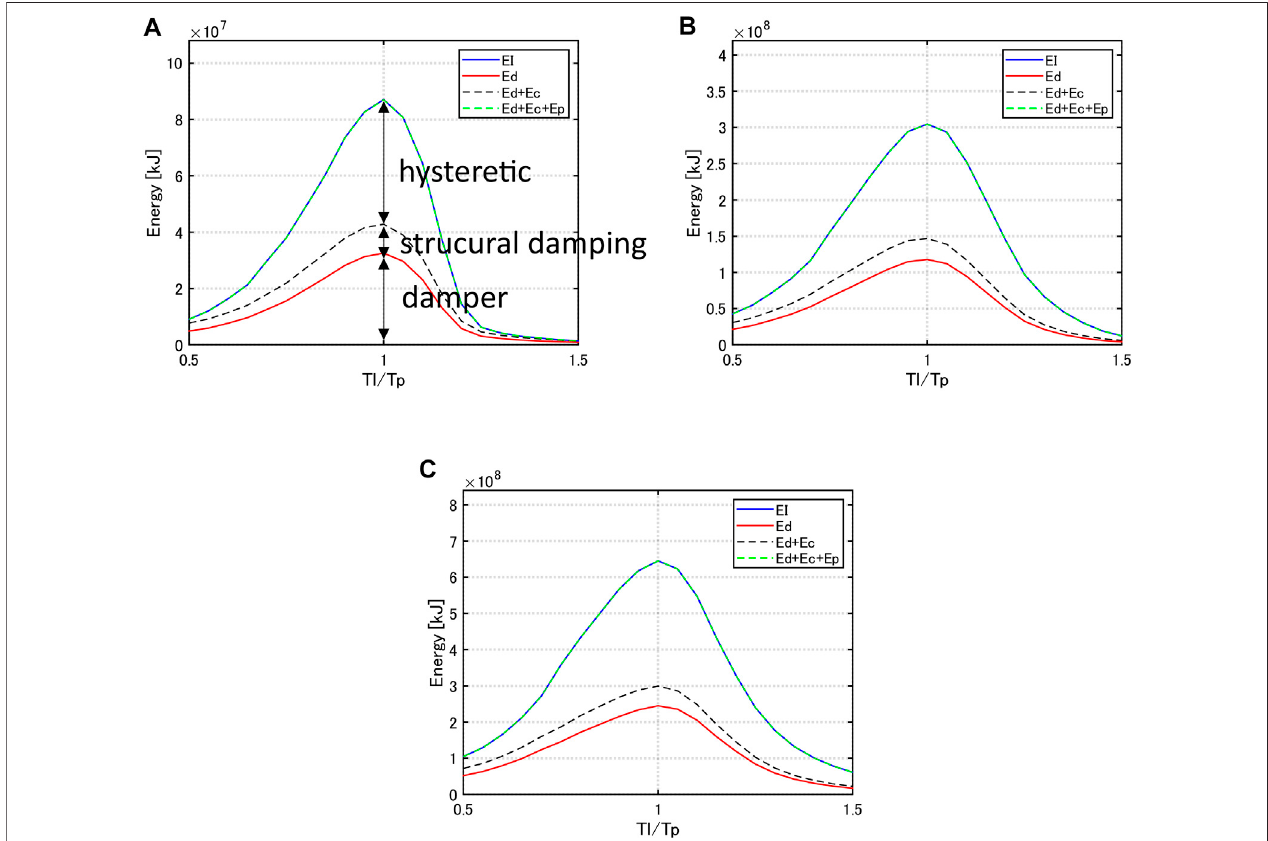
FIGURE 8 | Input energy with respect to period of equivalent sinusoidal wave (steady-state phase of equivalent 10-cycle sine wave), (A) V MI (cid:1) 0 . 20 [ m / s ] , T p (cid:1) 3 . 04 [ s ] , (B) V MI (cid:1) 0 . 40 [ m / s ] , T p (cid:1) 3 . 32 [ s ] , (C) V MI (cid:1) 0 . 60 [ m / s ] , T p (cid:1) 3 . 52 [ s ] .